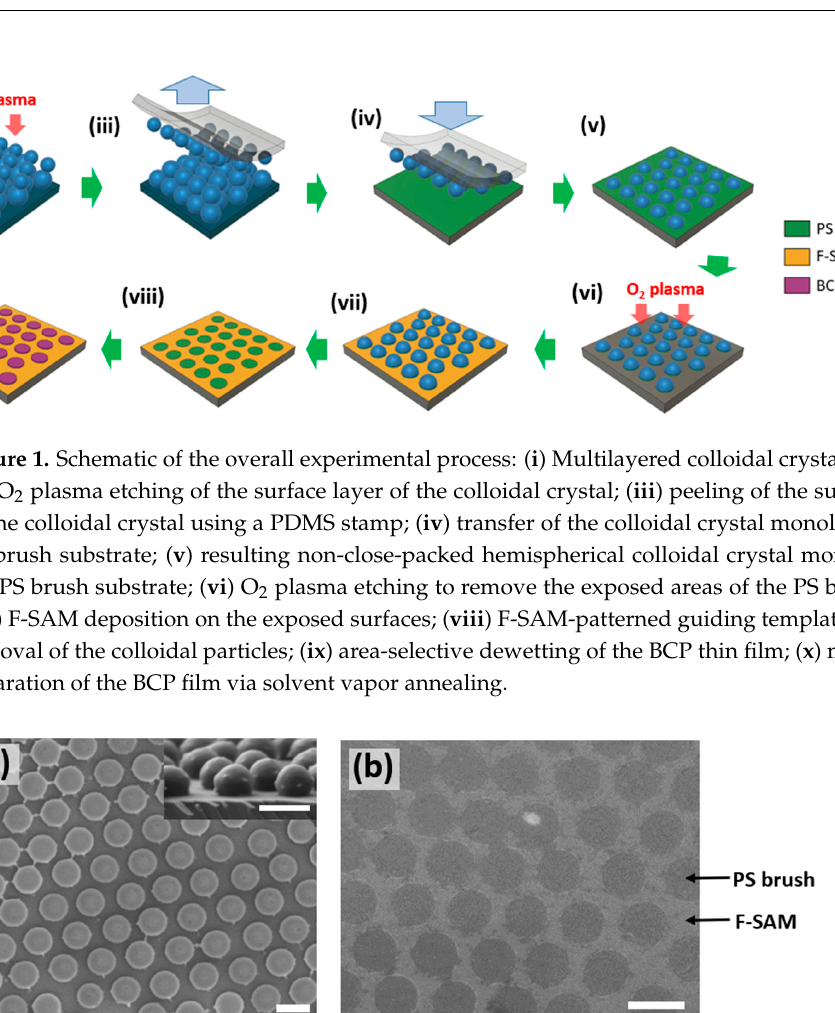
Figure 2. ( a ) SEM images of the vertical and lateral (inset) views of the transferred non-close-packed hemispherical colloidal crystal monolayer. ( b ) SEM images of the F-SAM/PS brush-patterned substrate after colloid removal. Darker and brighter regions represent the PS brush-coated and F-SAM-treated areas, respectively. All scale bars represent 400 nm.